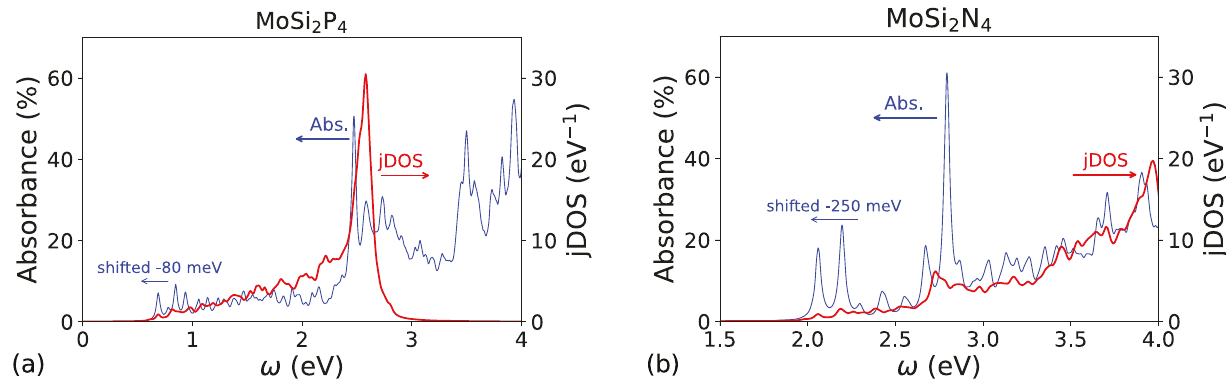
Fig. 6 jDOS and absorbance. jDOS per unit cell (red line) and absorbance (blue line) of a MoSi 2 P 4 and b MoSi 2 N 4 . The jDOS is obtained from the PBE eigenvalues and only comprises transitions involving the VBM − 1, VBM, CBM, and CBM + 1. The absorbance is shifted to match the jDOS, as reported in each